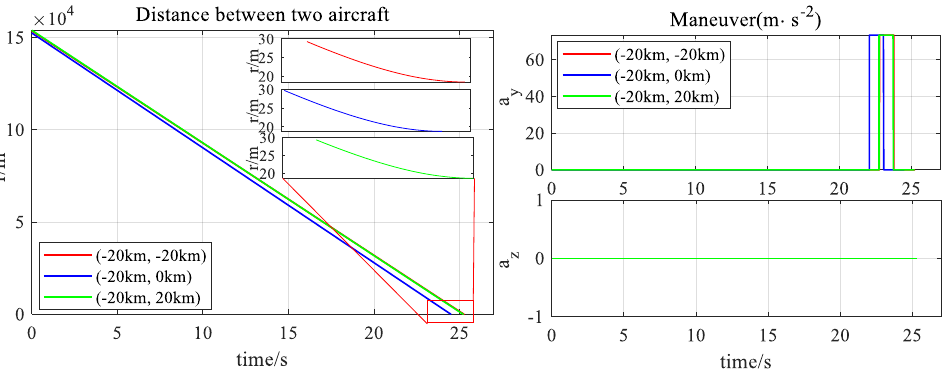
Figure 10. Evader utilizing MS-DDQN maneuvers with the three different initial relative positions ( − 20km, − 20km ) , ( − 20km,0km ) , and ( − 20km,20km ) in the initial inertial coordinate